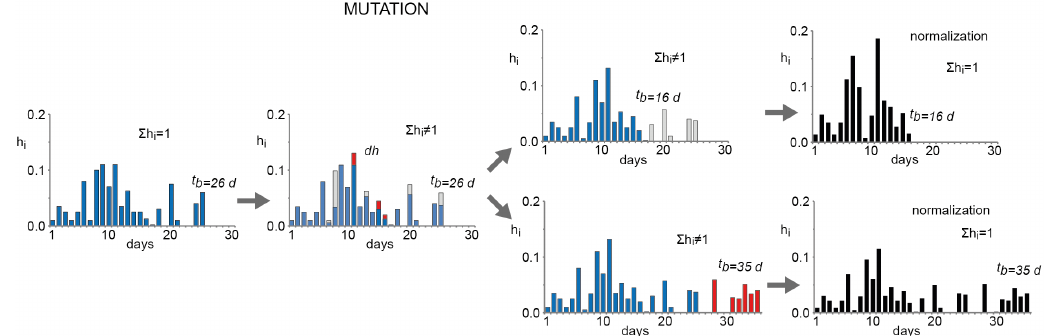
Figure 4. Examples of mutation. On the left, the genetic code of the parent individual (elements in blue). In the second histogram, mutation is applied to some elements of the parent (in red, added amounts; in grey, subtracted amounts). Then, the base time can either be decreased (upper sequence) or increased (lower sequence). Finally, the children are normalized (black elements) to ensure the validity of Eq. (2).